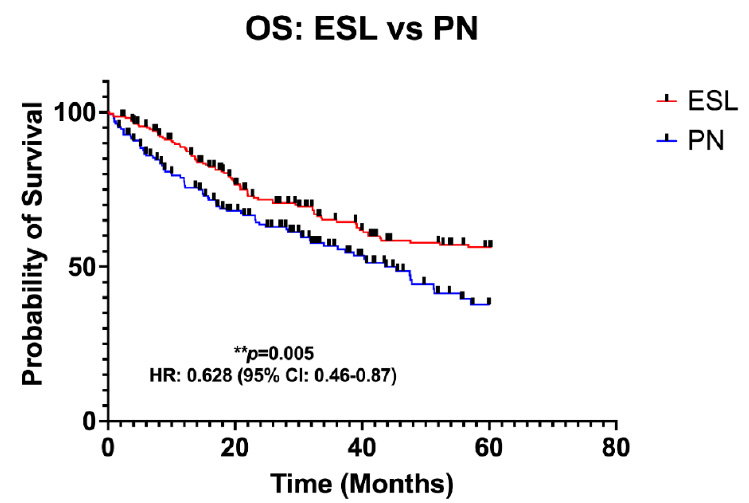
Figure 4. Pooled Kaplan–Meier curve for overall survival (OS) with extended sleeve lobectomy (ESL) compared to pneumonectomy (PN). CI, confidence interval; HR, hazard ratio. ** indicates significant difference.